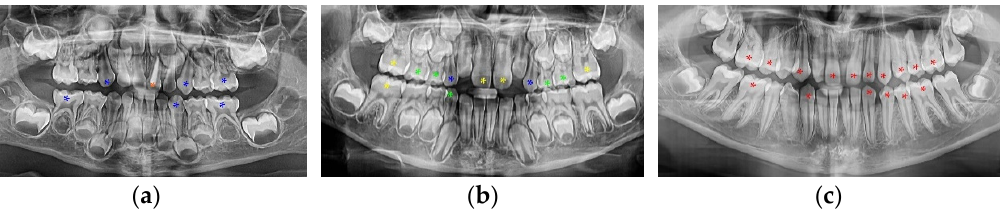
Figure 2. OPGs of children aged 3 years old ( a ), 8 years old ( b ), and 15 years old ( c ). The teeth considered suitable for SpO 2 measurements were marked with color-coded asterisks (*) as follows: G1 is indicated in blue, G2 is indicated in green, G3 is indicated in yellow, G4 is indicated in red, and G5 is indicated in orange.